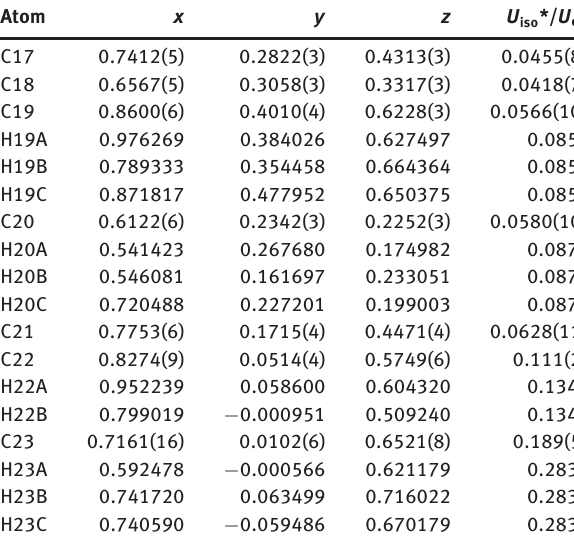
Table 2: Fractional atomic coordinates and isotropic or equivalent isotropic displacement parameters (Å 2